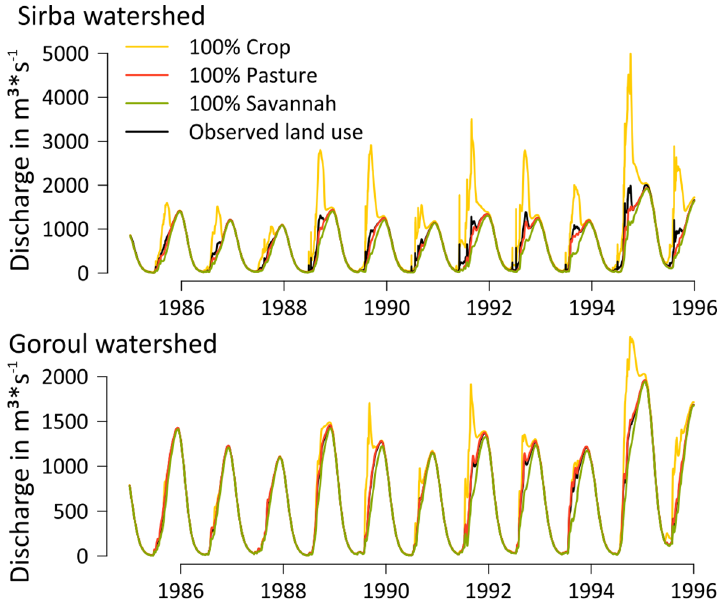
Figure 7. Comparison of discharges with four different land use coverages (100% crop, 100% pasture, 100% Savanna and land use as observed) for the Sirba and Goroul